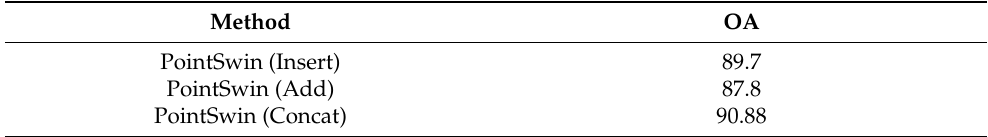
Table 9. Results of ablation experiments about the modules combination